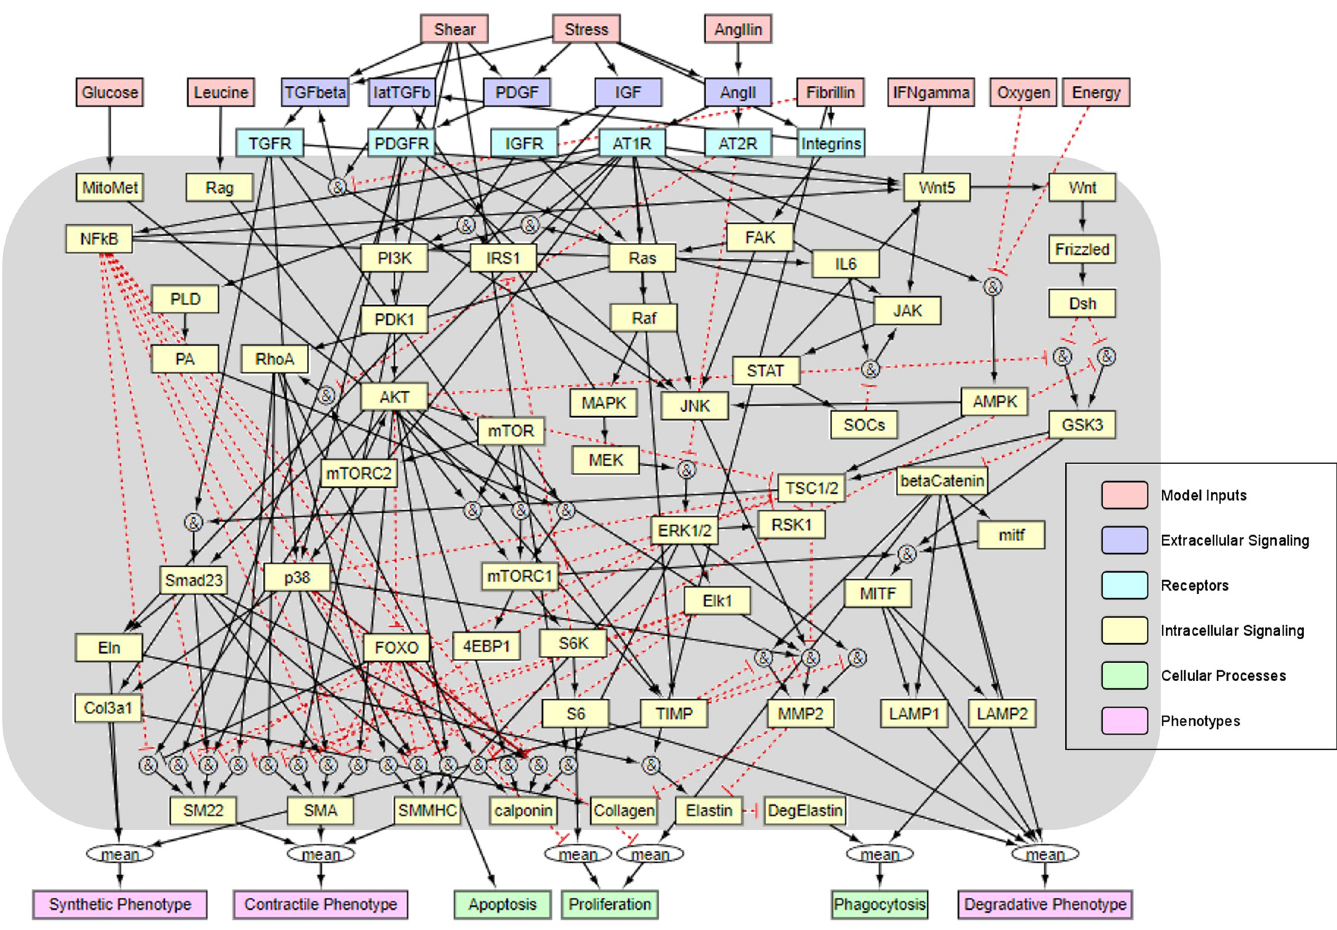
Fig 1. Schematic rendering of the smooth muscle cell network model featuring 81 nodes (species) and 138 edges (reactions), including model inputs (light red), extracellular signaling molecules (blue), cell-surface receptors (cyan), and intracellular signaling species (yellow). The activation level (bound from zero to one) of specific species was used to estimate the level of cellular processes (light green) and degree of phenotypic modulation (light purple) of the cell. See Table A in S1 Text for details on the reactions and the associated 105 references upon which this model was built.